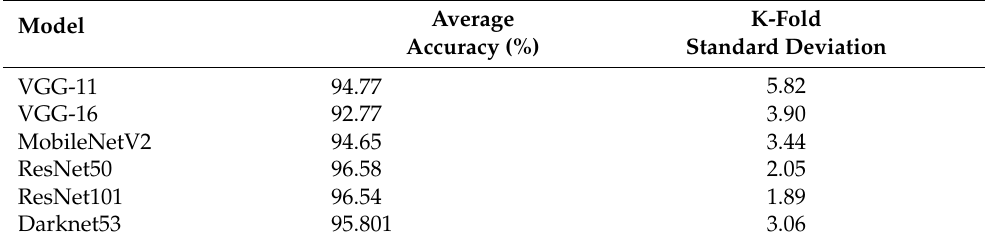
Table 2. Statistical measures for dirt